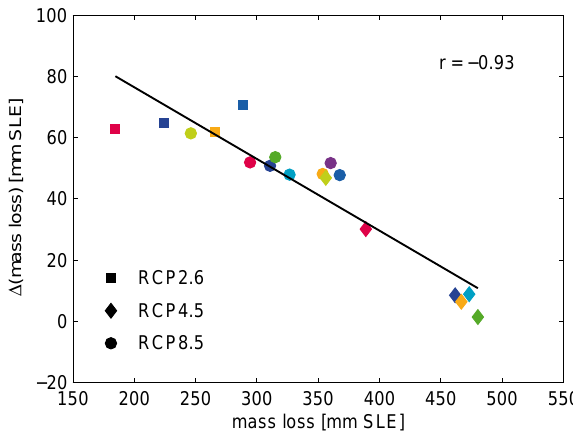
Fig. 11. Summary of the effect of glacier terminus retreat to higher altitude on glacier-mass loss. Plotted are the anomalies in the year 2300 as a function of respective mass loss projected in Marzeion et al. (2012) at the same time. Colors as in Fig. 2. Different markers refer to different